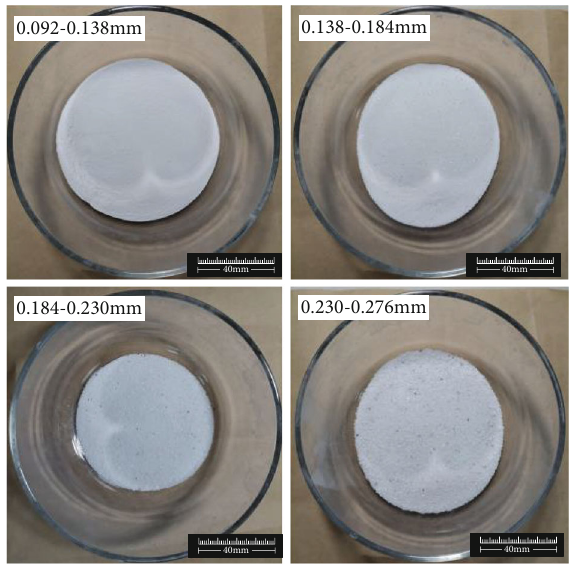
Figure 6: Various SiO sand.